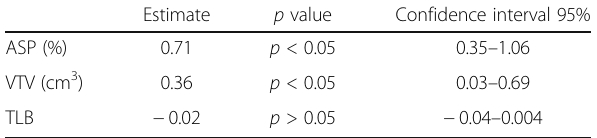
On multivariable analysis using ordinal logistic regression, correlation of the ASP to GSc was independent against VTV and TLB. A comparable weaker effect was found for VTV as well. Abbreviations: ASP asphericity, VTV viable tumor volume, TLB total lesion binding